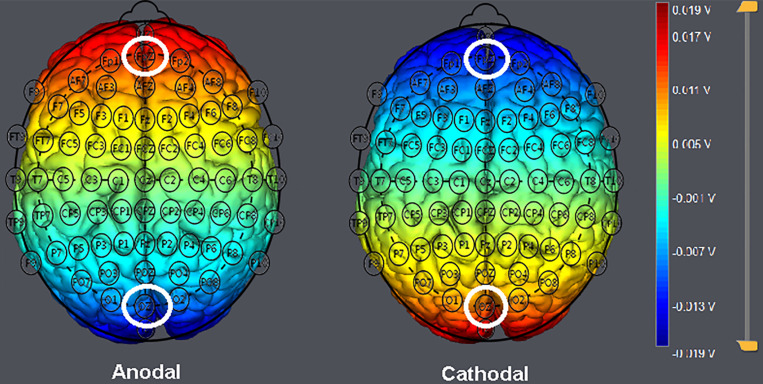
Locations of the electrodes and stimulation modes in transcranial direct current stimulation (tDCS) treatments. Schematic of electrode positions Fpz and Oz based on the international electroencephalography (EEG) 10–20 system of the human brain. The shading represents the range of input voltage from −0.019 to 0.019 V.